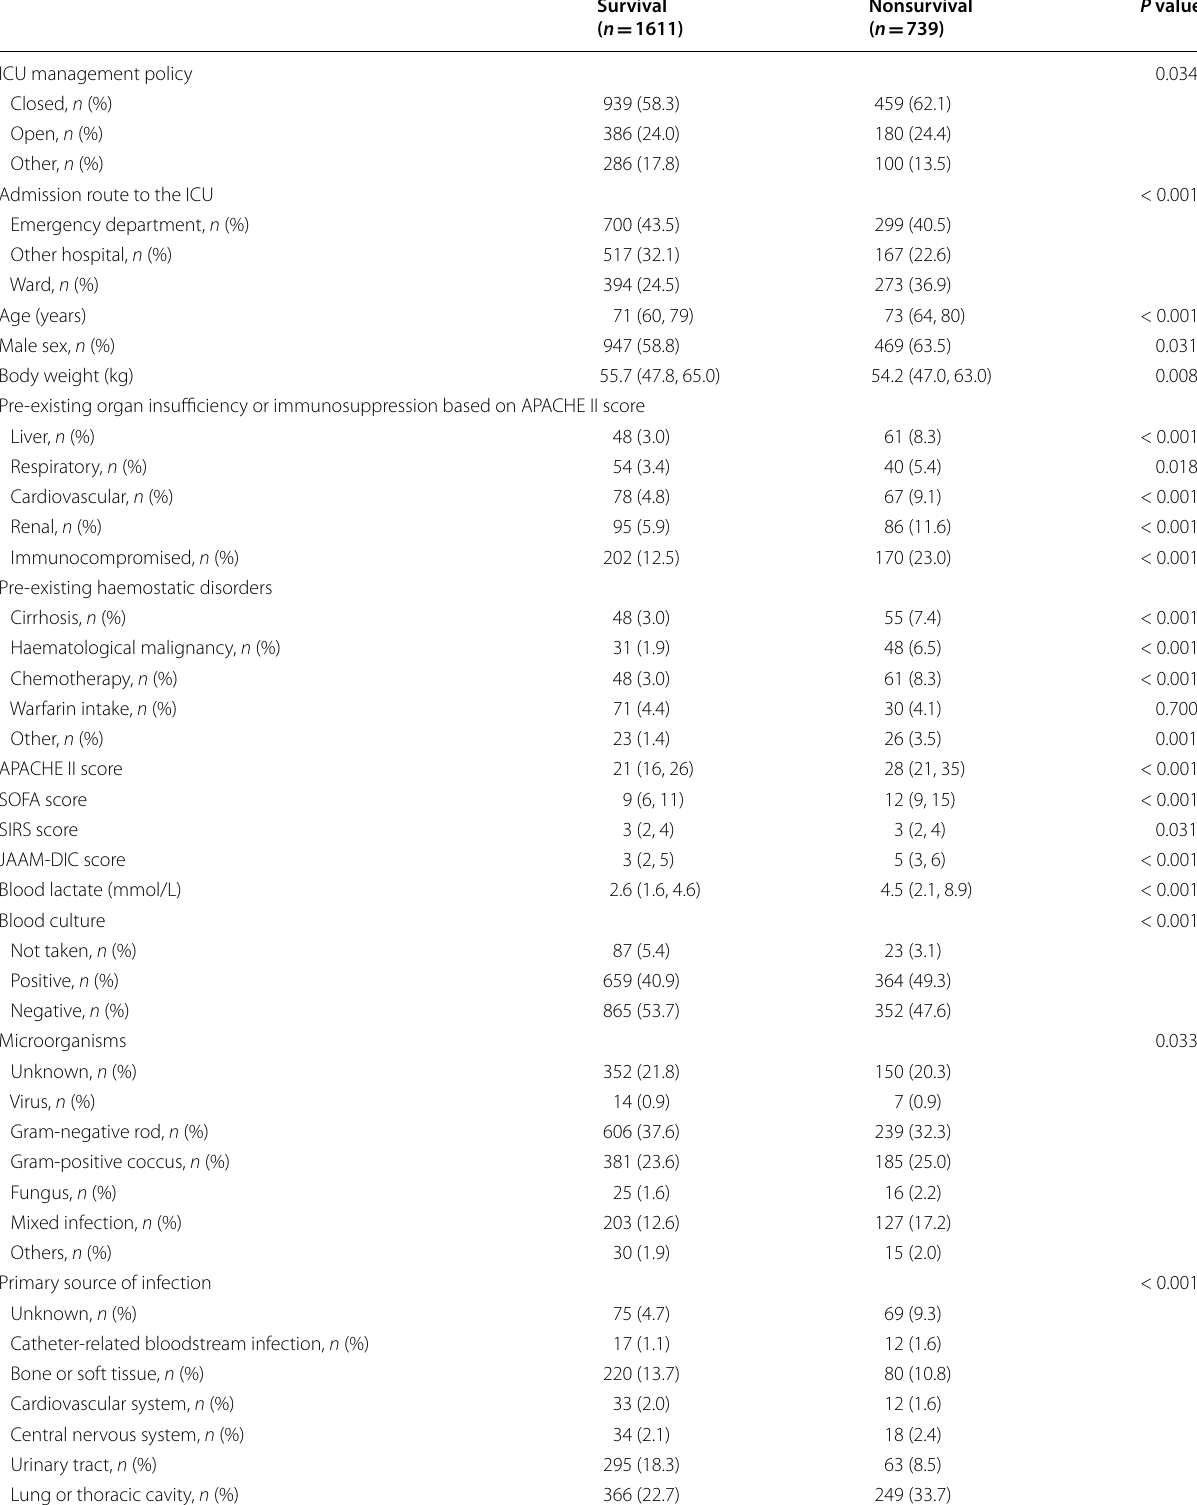
Table 1 Patient characteristics, therapies, and outcomes in the survival and nonsurvival